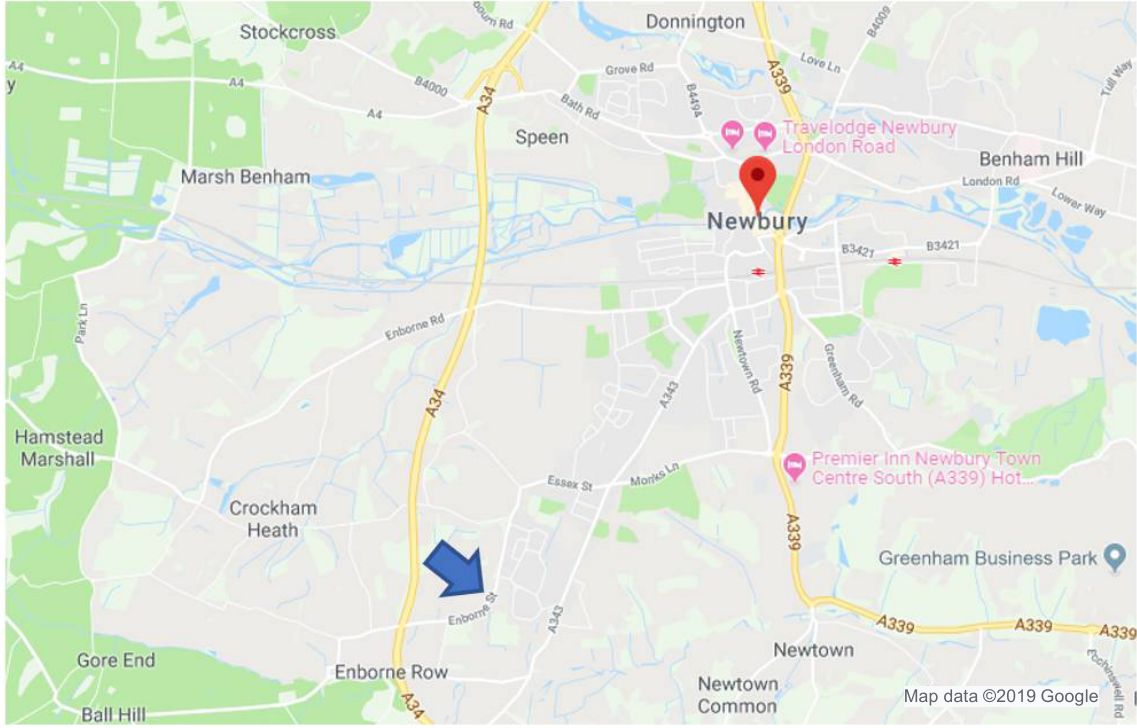
Figure 1. Location map of Newbury cutting with an arrow pointing to the site location [38].